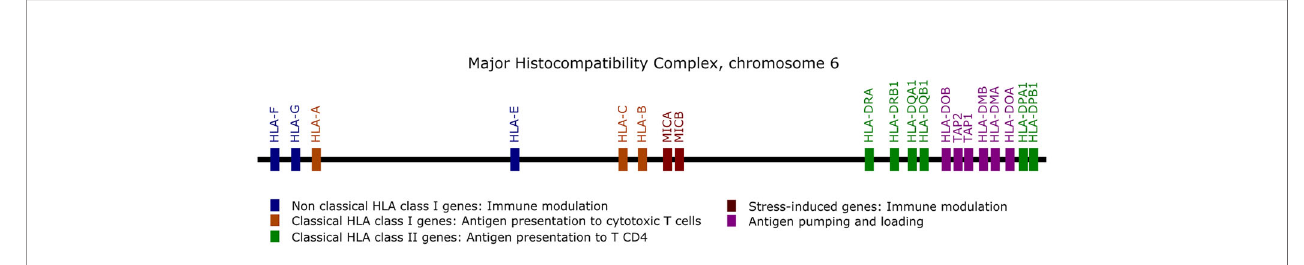
FIGURE 1 | List of the genes optimized by the hla-mapper program in the Major Histocompatibility Complex